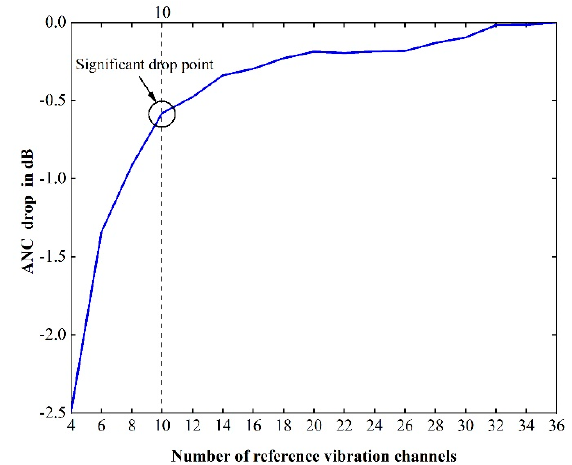
Figure 4. The predicted performance (overall reduction) of pure feedforward control system using different numbers of vibration channels.